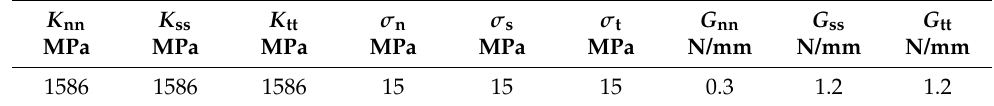
Table 4. Parameters of cohesive